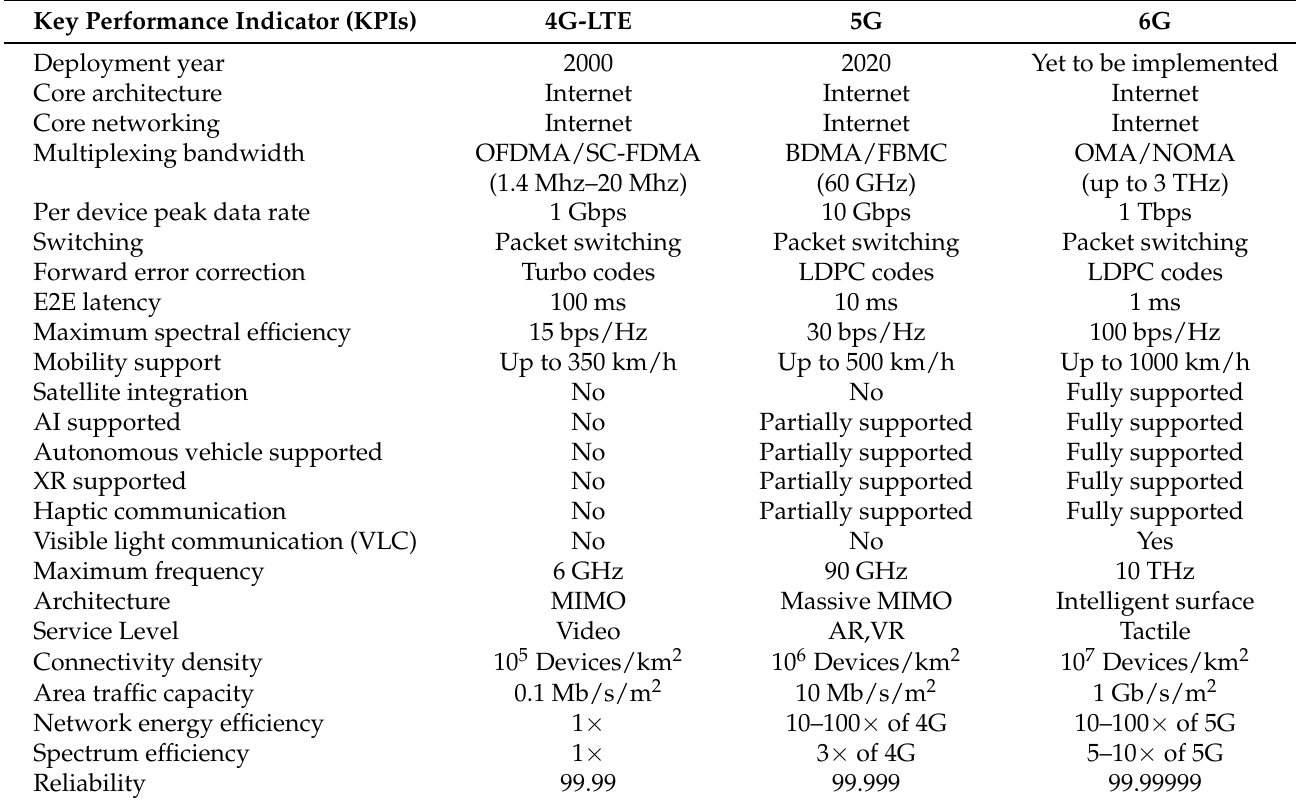
Table 1. Comparison of 4G, 5G, and 6G communication